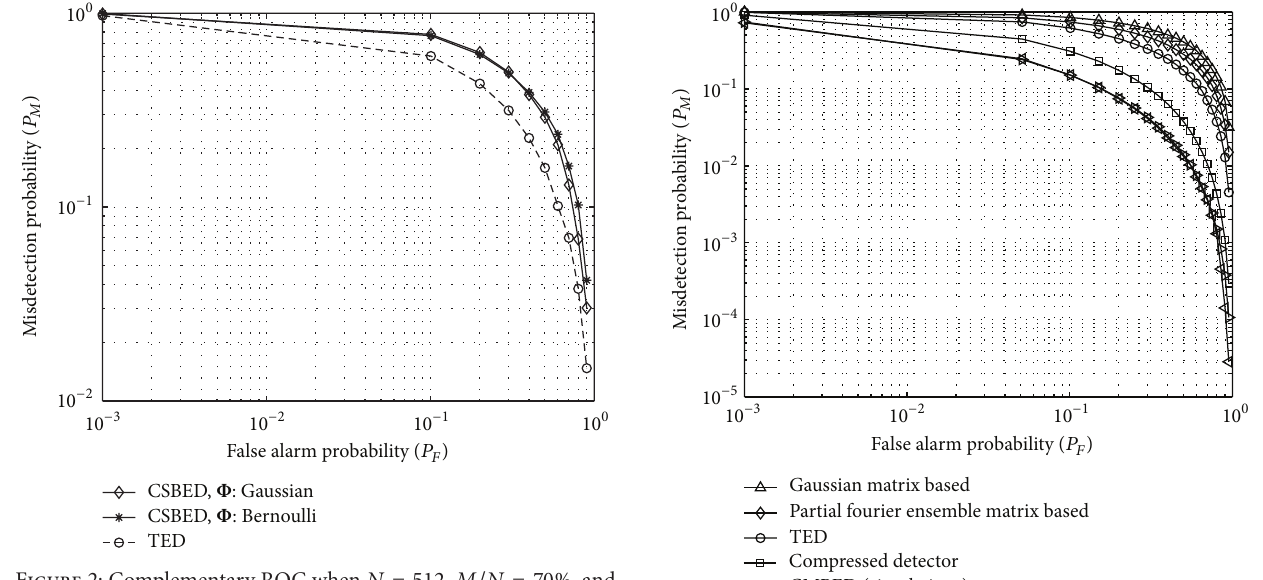
Figure 2: Complementary ROC when 𝑁 = 512 , 𝑀/𝑁 = 70 %, and 𝛾 = 15 dB.